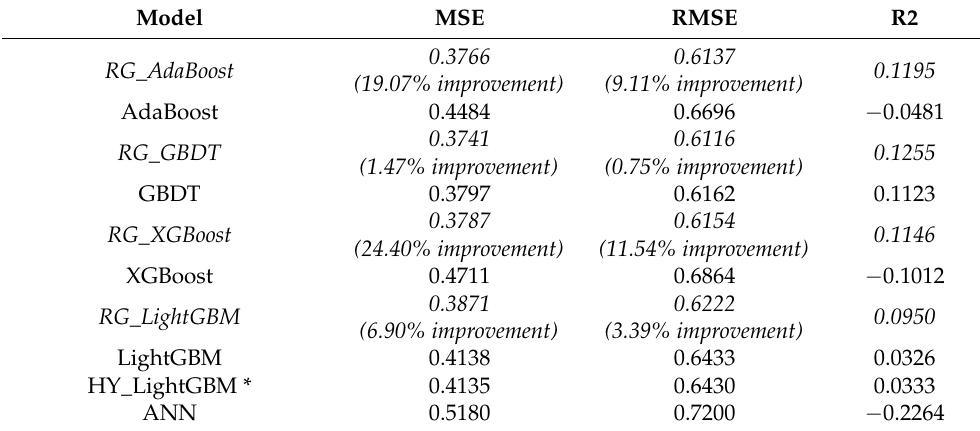
Table 4. The blood glucose level prediction improvement, in terms of MSE, RMSE and R 2 , of RG-enriched boosting ensemble learning models against corresponding original